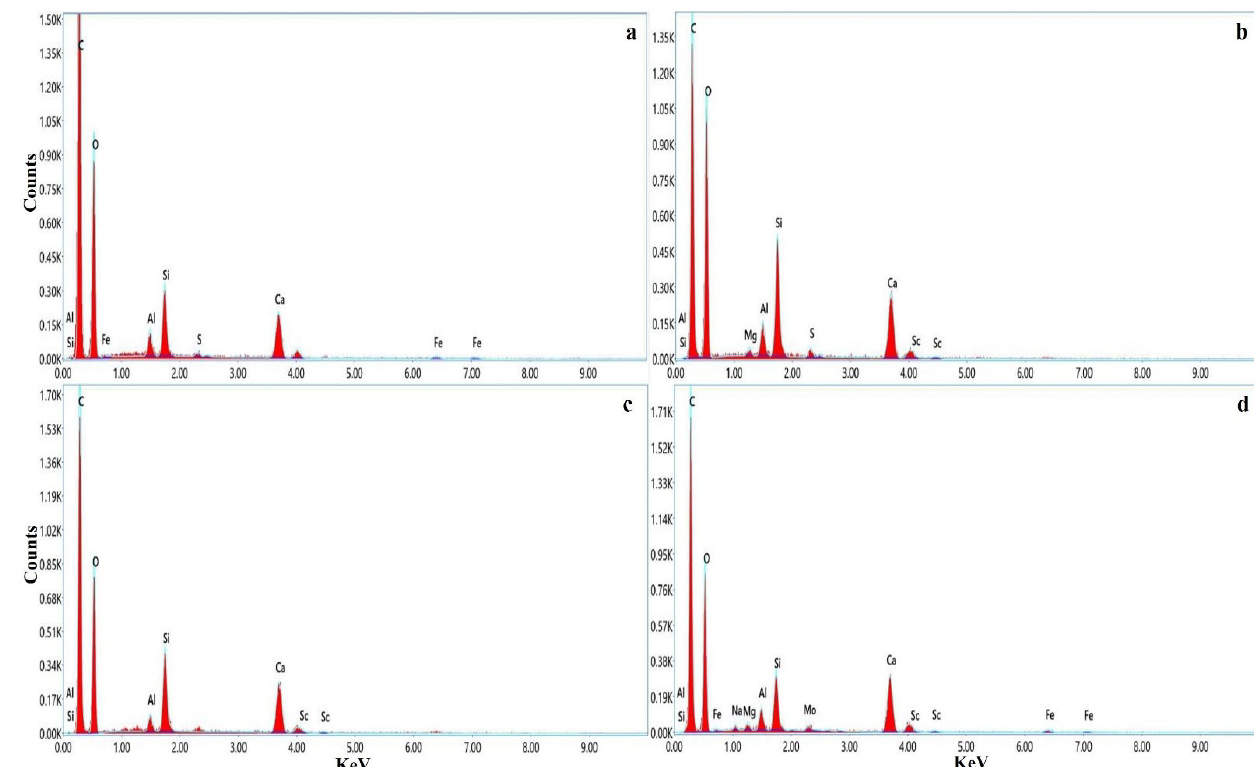
Figure 19. EDX spectrum of ( a ) Fine silica sand concrete, ( b ) coarse silica sand concrete, ( c ) river sand concrete and ( d ) M sand concrete.